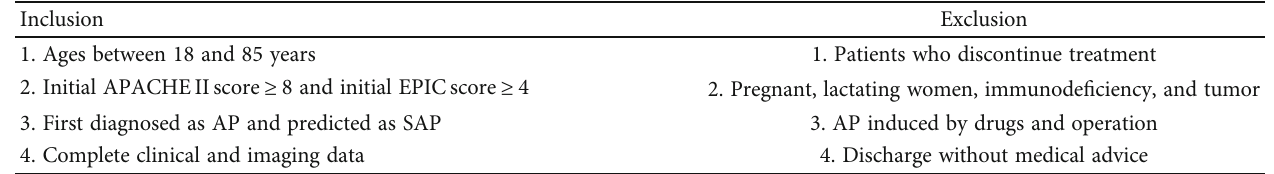
Table 1: The inclusion and exclusion criteria.